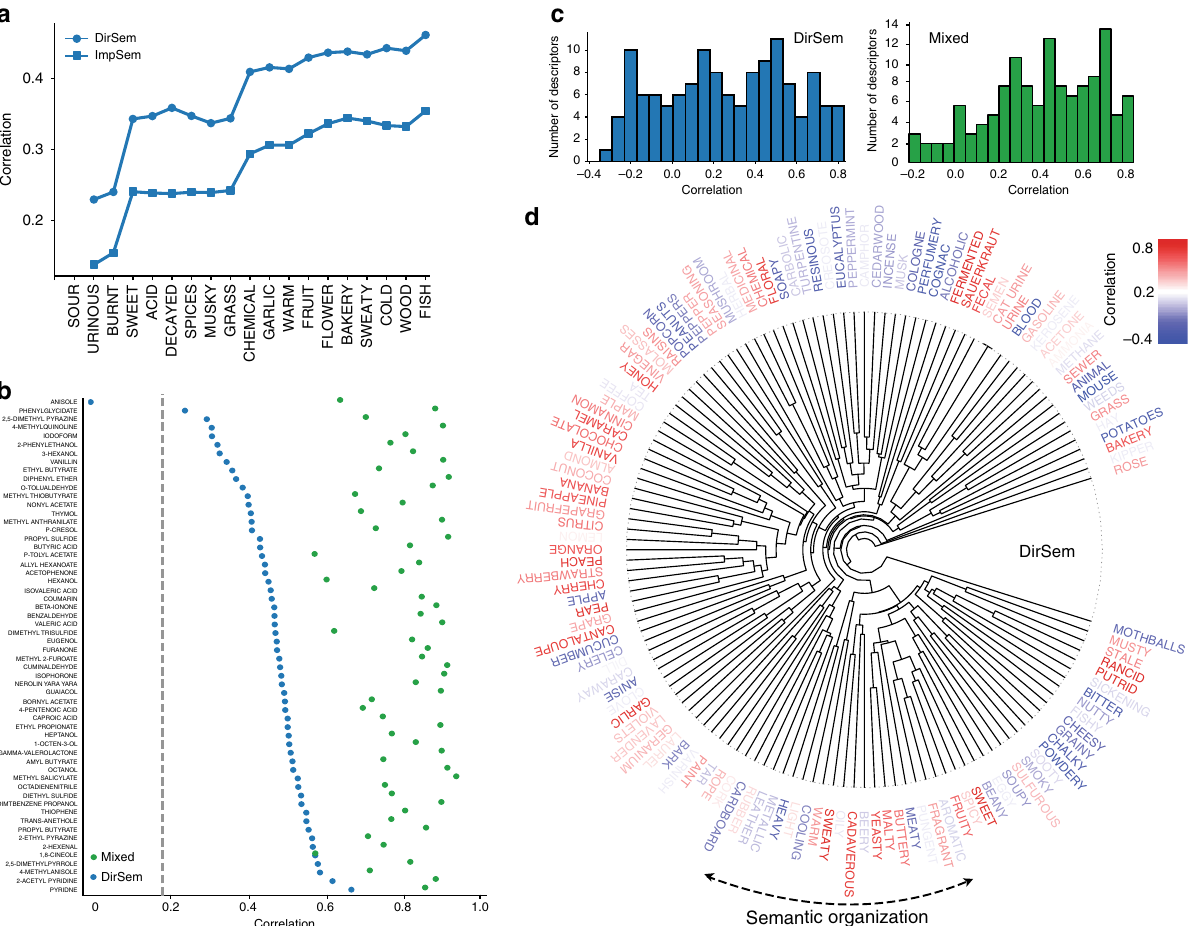
Fig. 4 Analysis of predictive performance and map structure. a The performance of the direct semantic DirSem and the imputed semantic ImpSem models (open blue circles and squares, respectively) as the number of descriptors used during training is increased. b Prediction performance for each molecule, as measured by average correlation across descriptors between the ground truth ratings and the ratings predicted by the DirSem and mixed models (blue and green dots, respectively). The best-predicted molecules are toward the bottom of the chart, limit of signi fi cance (for DirSem model) is shown by the dotted gray line. c Histograms showing the median correlation across molecules for each descriptor for left the DirSem model and right the mixed model. d Odor wheel: prediction performance for each descriptor — as measured by the correlation across molecules between the ground truth and the predictions from the DirSem model — is indicated by the color of the text (see bar for scale). Descriptors are arranged and clustered based on their semantic